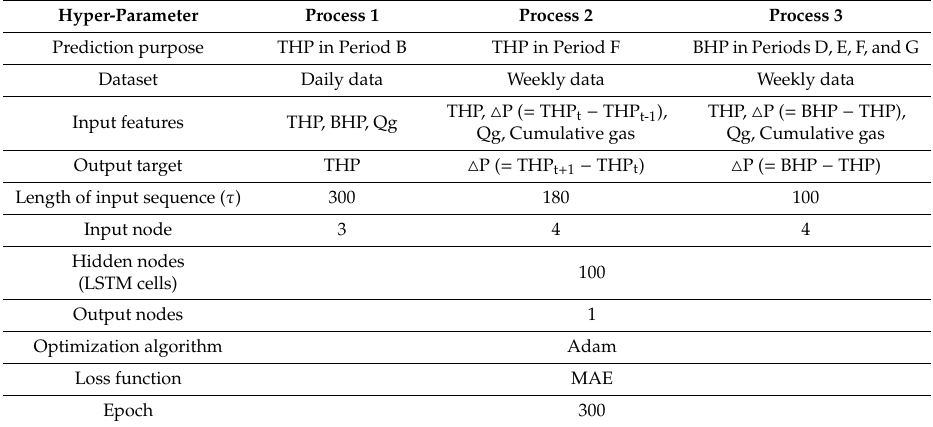
Table 2. Hyperparameters of the RNN-LSTM methods for the three